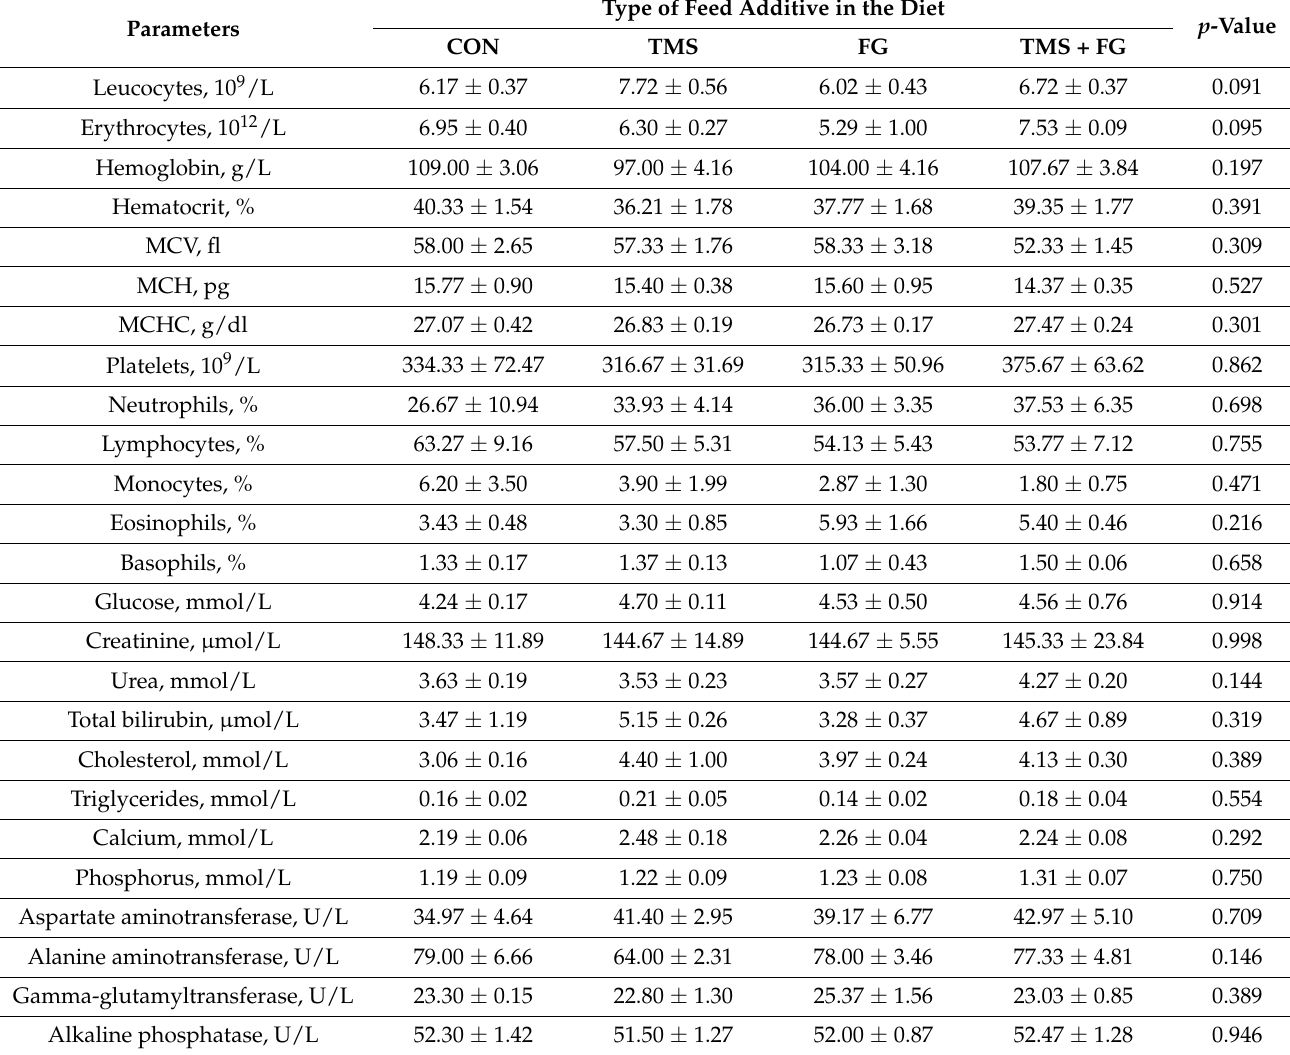
Table 8. Blood biochemical parameters of Suksun dairy breed (30